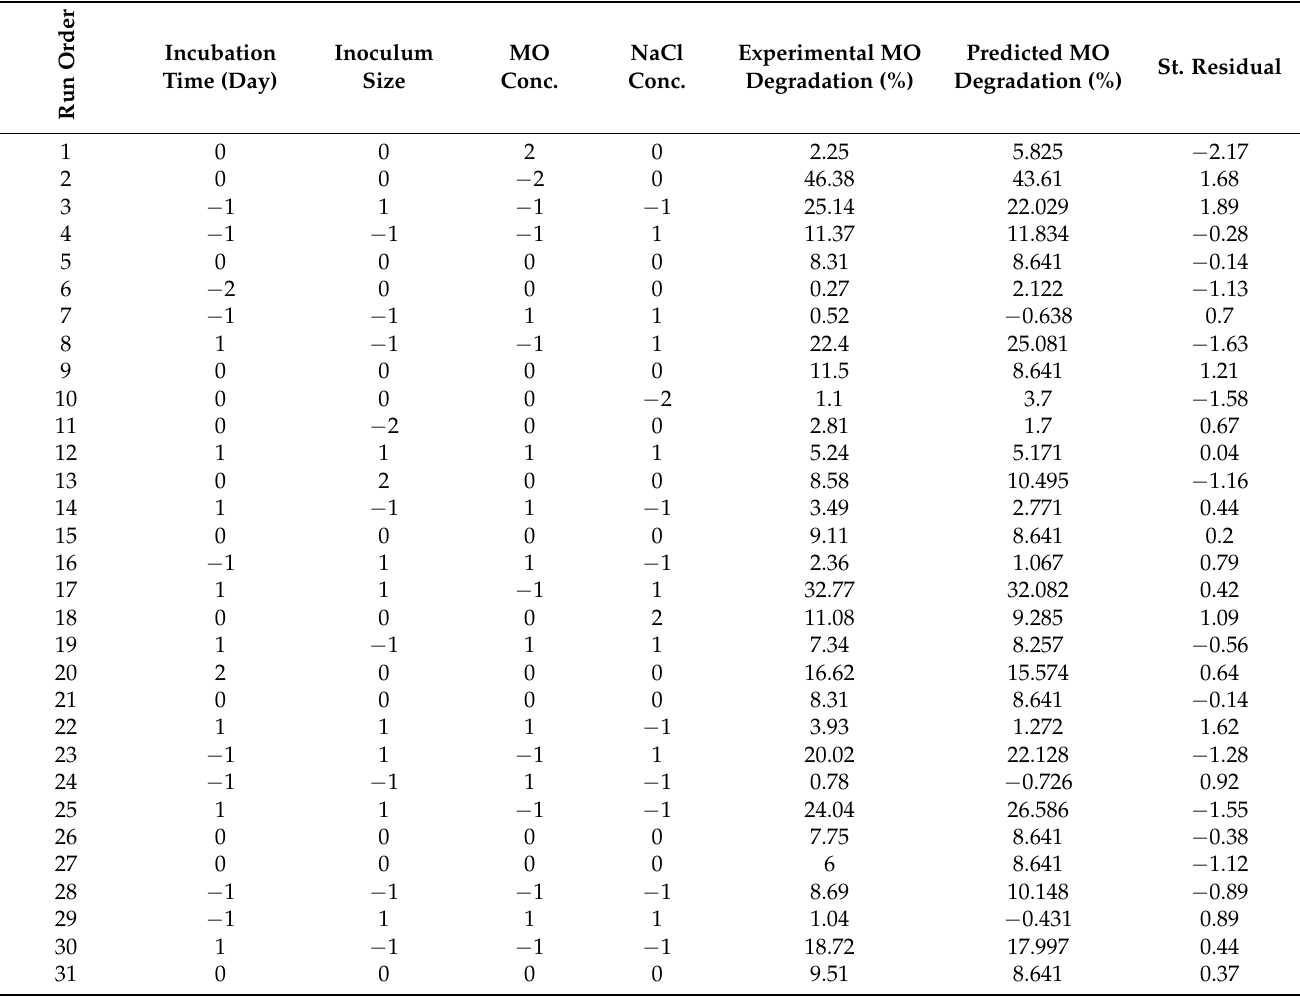
Table 2. Central composite design (CCD) matrix of MO degradation using immobilized consortium influenced by incubation time, inoculum size, MO and NaCl concentrations along with the predicted responses and